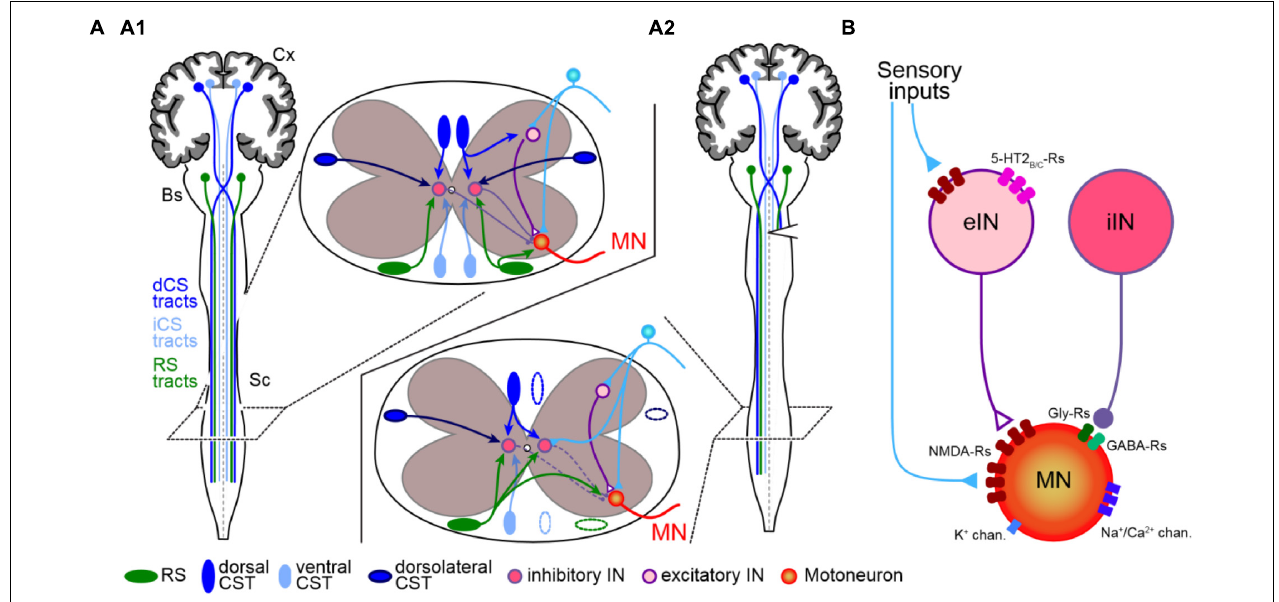
FIGURE 3 | Spinal network reorganization after unilateral spinal cord injury. (A) The symmetrical organization of uncrossed (light blue) and crossed (dark blue) corticospinal and reticulospinal (green) projections (illustrated in upper inset) and local sensory inputs (cyan) onto segmental INs (pink) and MN (orange) in control animal (A1) exhibit adaptations below spinal cord hemisection (A2) ipsilesional sensory inputs invade IN and MN dendritic territories deprived from their ipsilateral descending projections, and contralateral descending axons sprout terminals into the ipsilesional hemicord. See text for details. Cx, cortex; Bs, brainstem; Sc, spinal cord; iCS and dCS, ipsilateral and decussating corticospinal tracts; RS, reticulospinal. (B) SCI-induced acute modifications in motor neuron (MN) and excitatory and inhibitory interneurons (eIN and iIN, respectively) intrinsic and synaptic properties leading to MN hyper-excitability. Sensory-evoked responses are enhanced due to increased expression of NMDA receptors (NMDA-Rs) in both MN and eIN, and increased expression of serotonin receptors (5-HT2 B / C -Rs) in eIN. In contrast, inhibitory influences from iIN onto MN are reduced due to lower motoneuronal expression of GABA and glycine receptors (GABA-Rs and Gly-Rs, respectively). In addition, overexpression of sodium/calcium permeant channels (Na + /Ca 2 + chan.) and lower expression of potassium channels (K + chan.) intrinsically increase MN excitability. The relative expression of membrane channels and receptors is illustrated as follows: one item shows a decrease and three items an increase compared to a “normal expression” of two